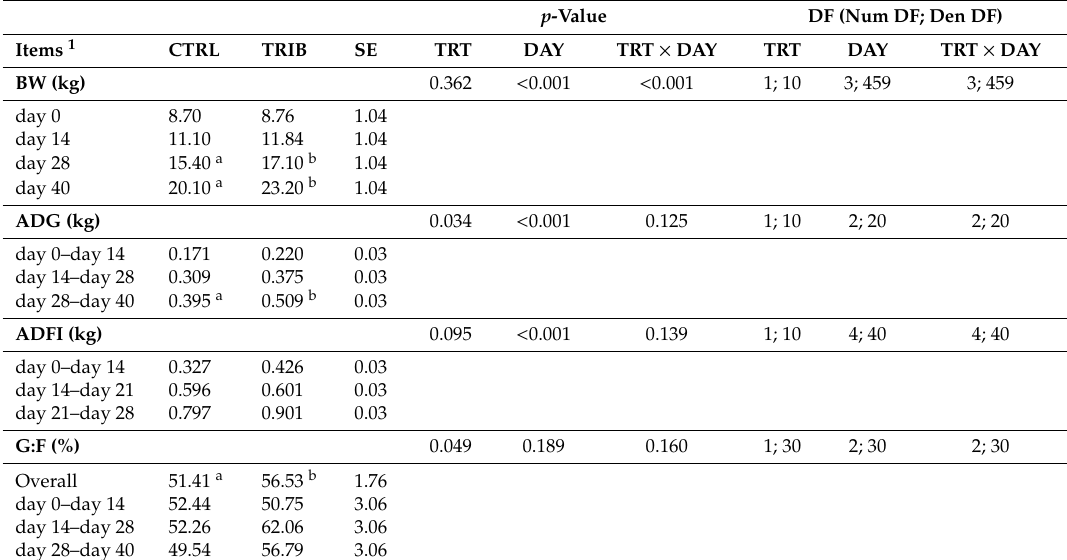
Table 2. Weight gain and feed conversion rate of piglets fed on a diet supplemented with (TRIB; n = 60) or without (CTRL; n = 60) 0.2% tributyrin during the entire experimental period.